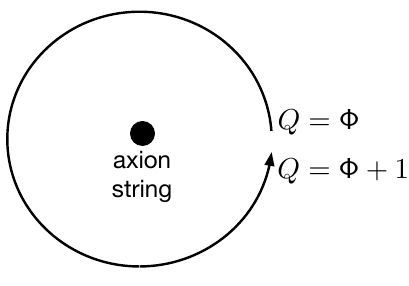
An axion string is characterized by the property that (cid:8) has monodromy (cid:8) ! (cid:8) + 1 around it. The electric charge of a magnetic monopole, which we denote as Q , changes after going around an axion